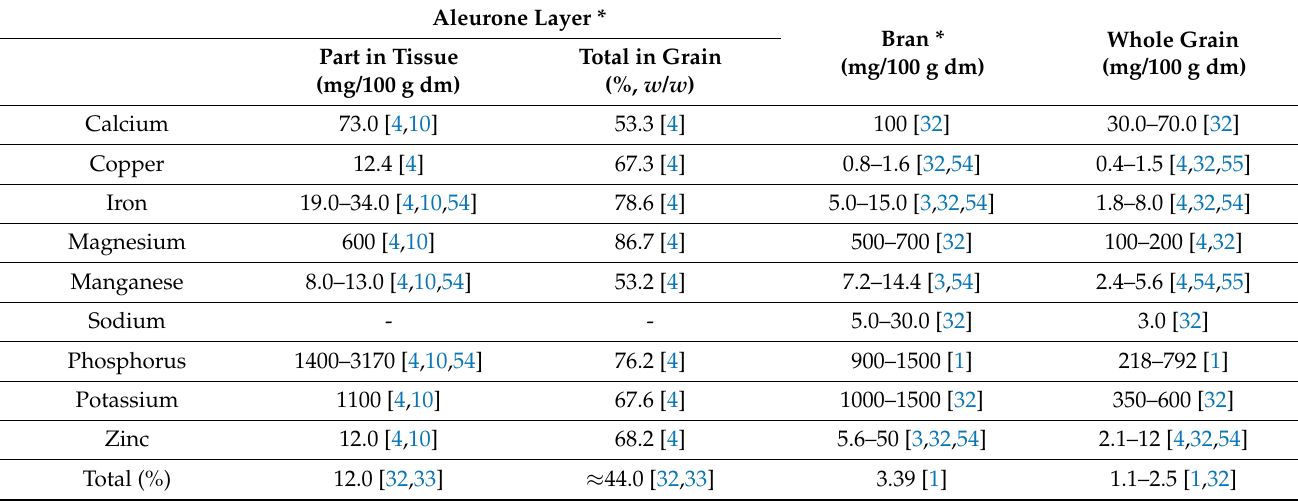
Table 4. Minerals repartition in the wheat aleurone layer, bran and whole grain.